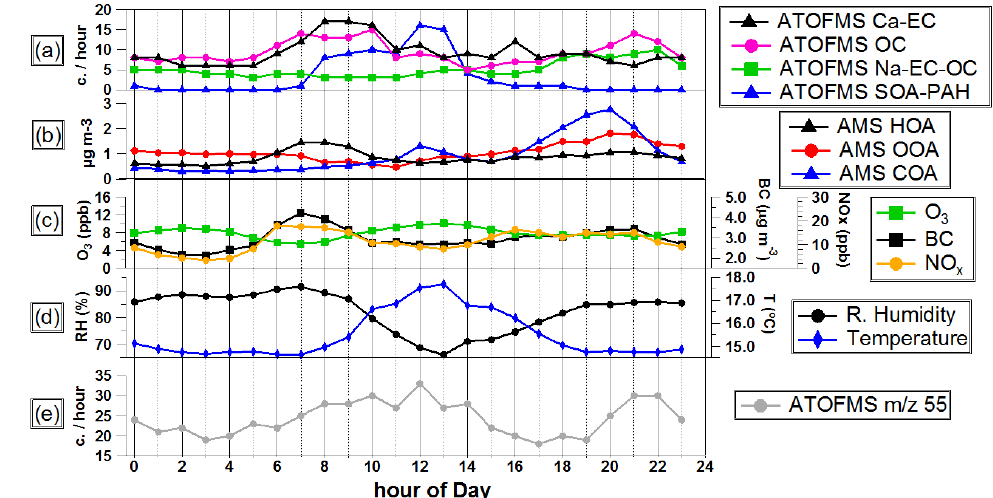
Fig. 5. Average diurnal profiles for (a) ATOFMS cluster described in Fig. 1, (b) AMS PMF factors as reported in Allan et al (2010); (c) ozone, NO x and black carbon concentrations; (d) relative humidity and temperature and (e) ATOFMS hit particles with m/z 55 (peak height >